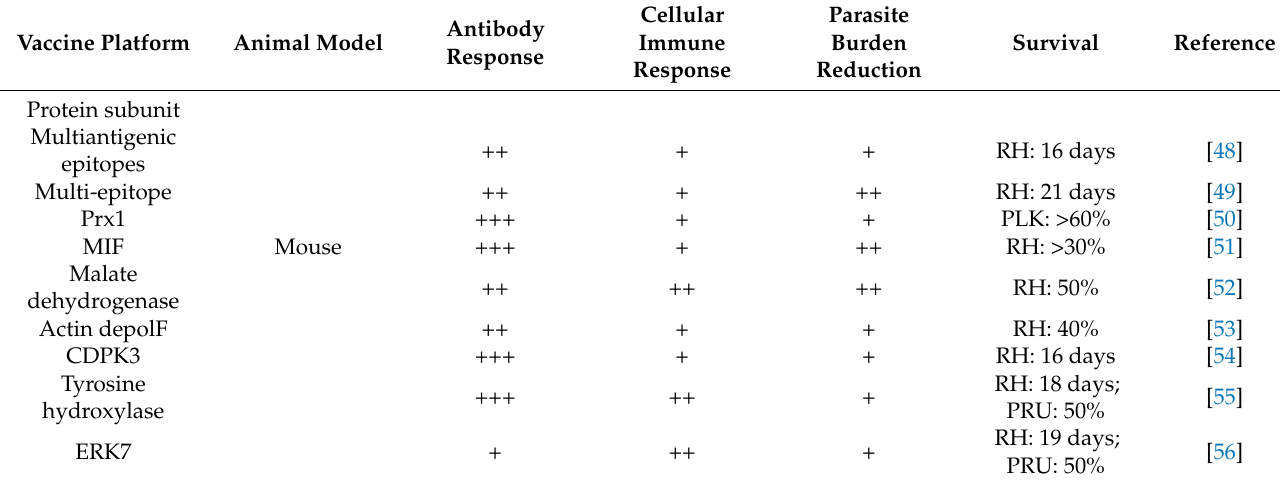
Table 2. An overview of the T. gondii protein and subunit vaccines and their efficacies. Only the studies that assessed all four of the parameters listed below were selected and referenced in the table. Survival refers to the total duration of survival for immunized mice. +, weak; ++ intermediate; +++